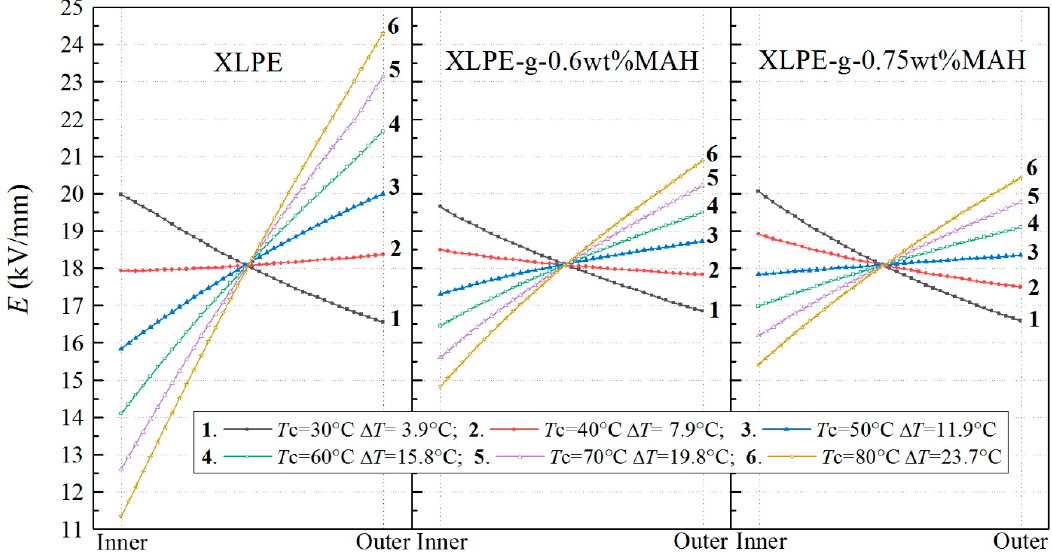
Figure 5. Simulated electric field distributions in insulation layers of a DC cable modeled with XLPE, XLPE-g-0.6 wt %MAH and XLPE-g-0.75 wt %MAH materials respectively.